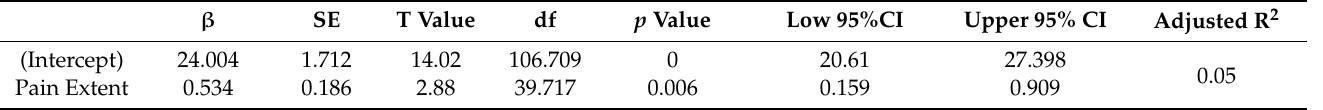
Table 4. Crude association between baseline pain extent to 1 year NDI outcome.